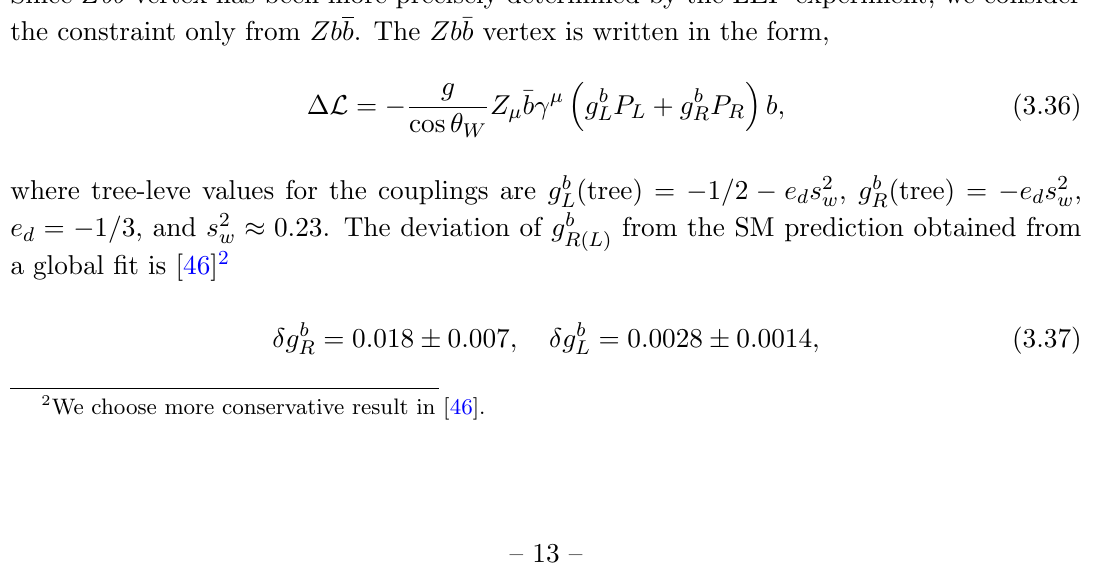
Figure 7 . The constraint from neutrino trident production and muon g The grey region is disfavoured by the neutrino trident production experiments at 2 (cid:27) . The region between the two green lines is favoured by the current discrepancy (cid:1) a (cid:22) at 2 (cid:27) , but it is excluded by the neutrino trident production experiments. The red \X" mark represents the benchmark point m Z 0 = 700 GeV and (cid:11) Z 0 = 0 :